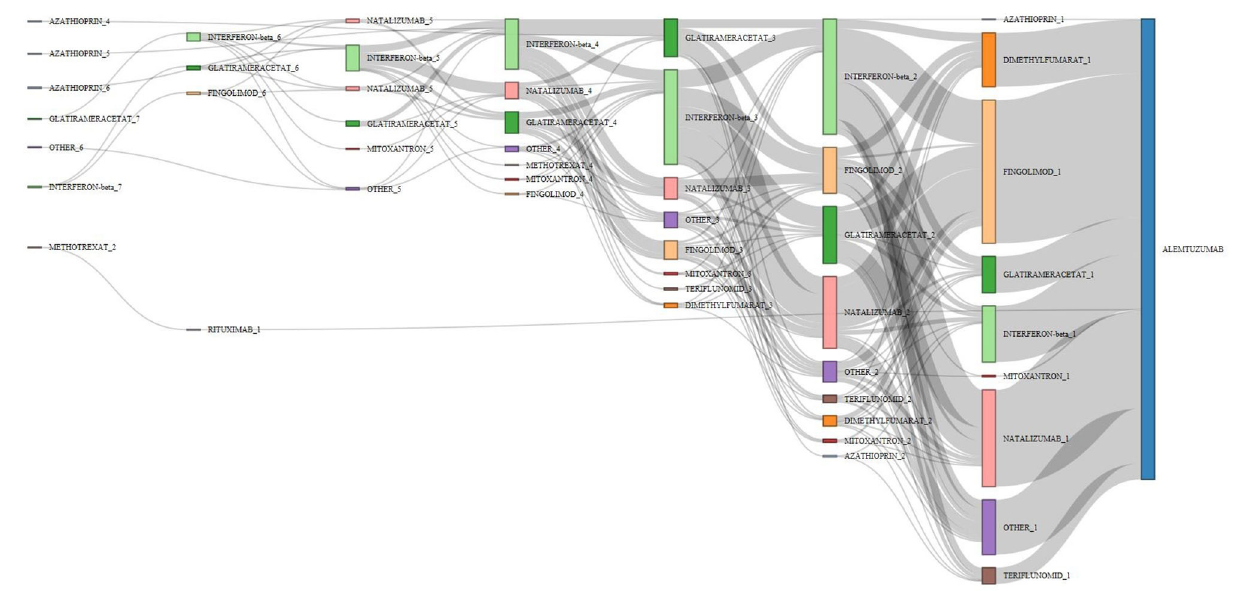
FIGURE 4 | Pathways of disease-modifying treatments (DMTs) before final switch to alemtuzumab. The figure displays the pathways of DMTs before the final switch to alemtuzumab (before or at the inclusion visit of the study). The various MS medications are represented by different colors (alemtuzumab blue, fingolimod light orange, interferon-beta light green, glatiramer acetate green); the height of the stacked vertical bar represents the number of patients treated with the respective MS medication. The width of the lines (ribbons) that connect the individual stacked columns visualizes the number of patients who are transferred to the same (same color) or another medication (different color). It is clearly visible by the wide ribbons that “typical” pathways in this study were from interferon-beta to natalizumab, from interferon-beta to fingolimod, and from natalizumab to fingolimod. Patients were excluded if the exact treatment order could not be determined (29 cases unknown, 127 no pretreatment, 104 last pretreatments not identifiable), leaving 623 patients in the chart. Chronological treatment sequence order starts on the left and ends with alemtuzumab on the right. See also editable Figure 5